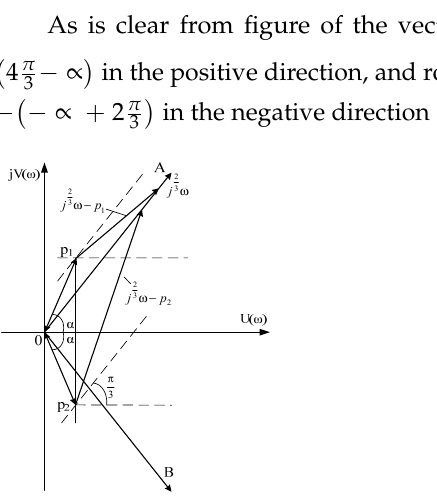
Figure 25. Vector displacement for the first two complex-conjugate roots for this case, when 𝜔 𝜖 (0, ∞) .